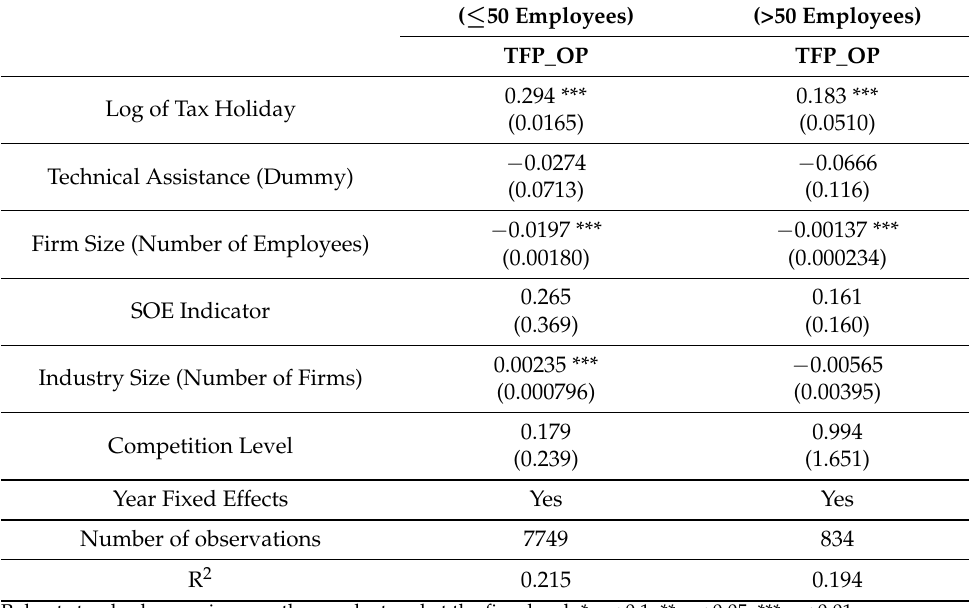
Table A9. Robustness Checks with Different Firm Size